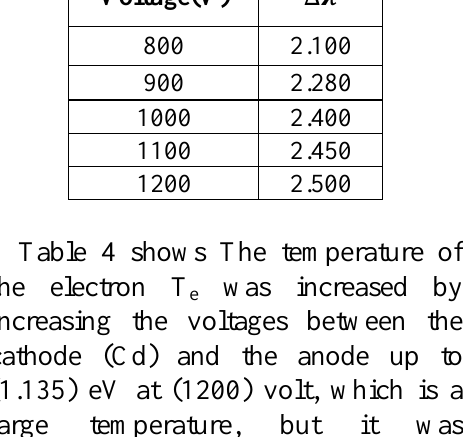
) for different voltage from 800 to 1200 p